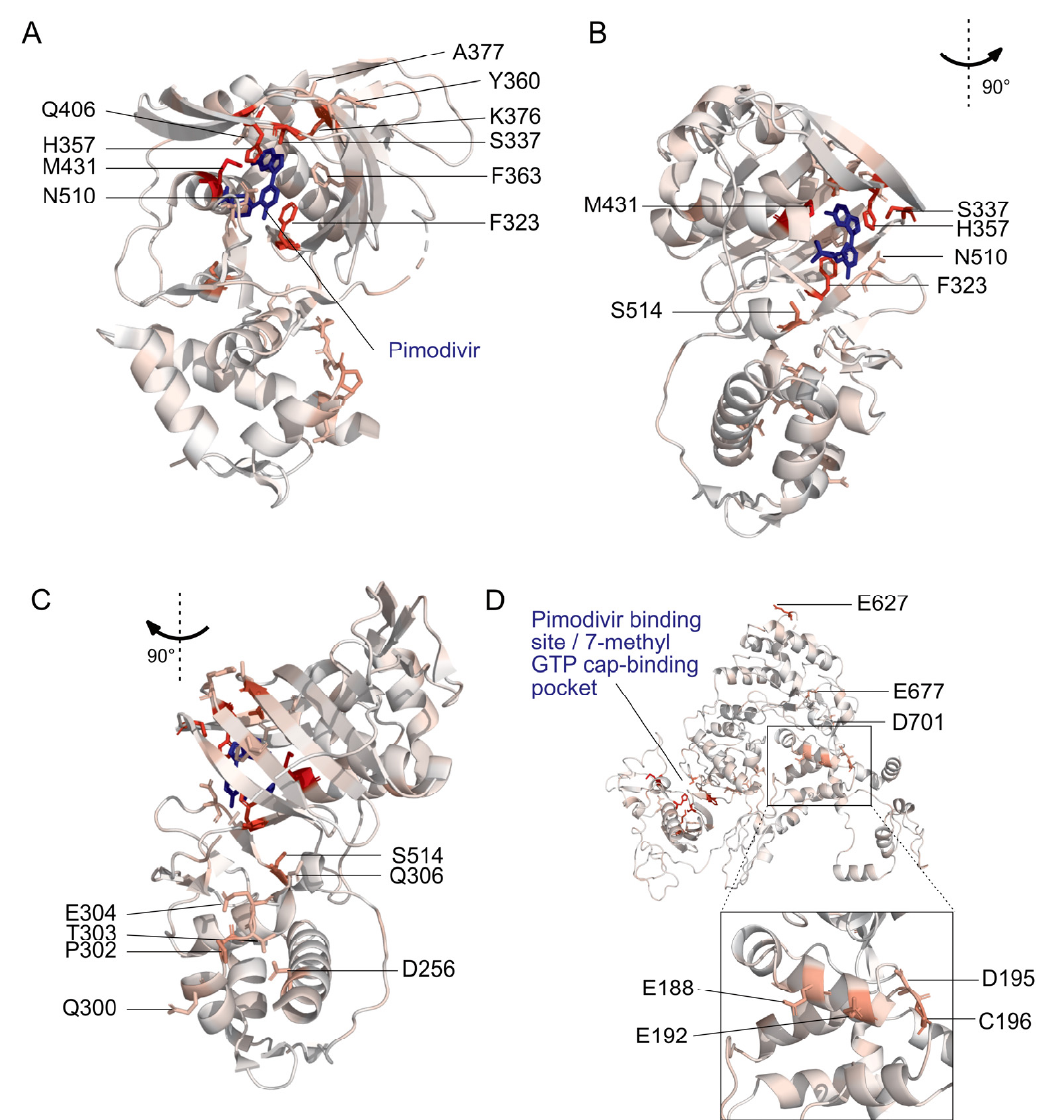
Figure 2. Locations of pimodivir resistance mutations on the PB2 protein. Amino acids are colored on a scale of white to red according to the total positive differential selection at that site, with red corresponding to a high differential selection. Sites of interest, as identified in Figure 1, are labeled. ( A – C ) Structural model of PB2 cap-mid-link double domain with pimodivir in the transcriptionally inactive “apo” configuration [25]. Sites with resistance mutations that are in the 7-methyl GTP binding pocket and mid-link domain are labeled here. PDB: 6EUV. ( D ) Structural model of full length PB2 in the apo configuration, but without pimodivir [31]. Sites of resistance mutations that are in the N-terminal domain and elsewhere are labeled here. PDB: 5D98. Supplemental Figure S3 accompanies this